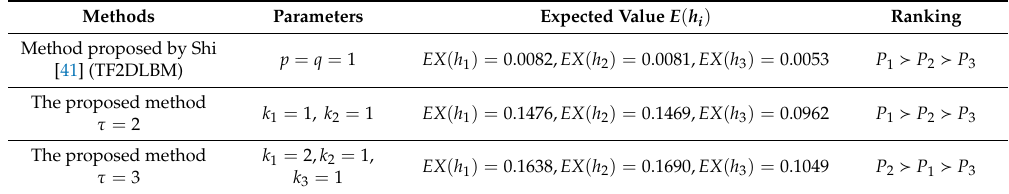
Table 9. Results obtained by di ff erent MADM